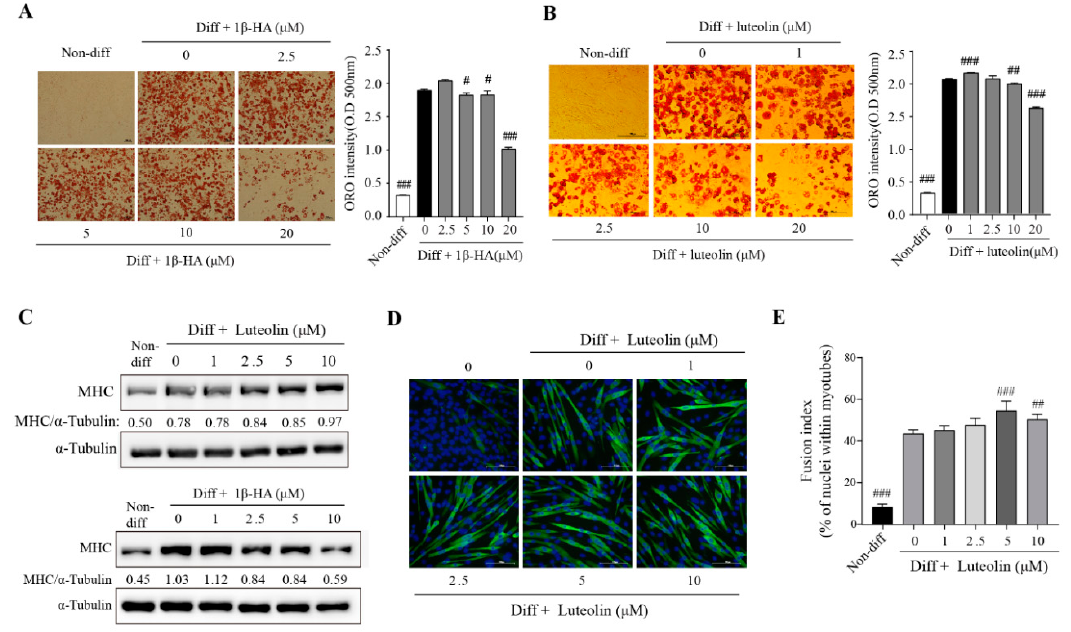
Figure 6. Effects of Luteolin and 1 β -hydroxyalantolactone (1 β -HA), active compounds of IJE, on adipogenic differentiation and myogenesis in 3T3-L1 and C2C12 cells. Inhibitory effects of ( A ) 1 β -HA and ( B ) luteolin on 3T3-L1 adipogenic differentiation were measured by Oil Red O staining (scale bar: 100 µ m). ( C ) Myosin heavy chain (MHC) protein level in differentiated C2C12 cells treated with luteolin (0–10 µ M) or 1 β -HA (0–10 µ M). ( D ) Immunostaining of MHC in luteolin-treated C2C12 cells (scale bar: 100 µm). ( E ) Fusion index of luteolin-treated C2C12 cells. Data are presented as mean ± SD of triplicate experiments. #, ##, and ### indicate p < 0.05, 0.01, and 0.001, respectively, when compared to the differentiated cells treated without 1 β -HA or luteolin. Diff, Differentiation.